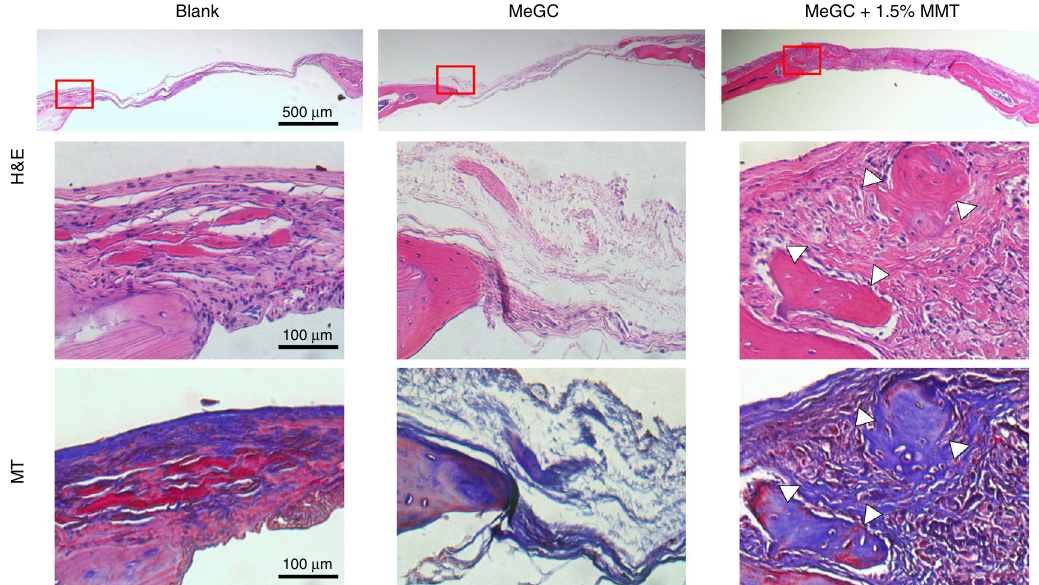
Fig. 9 Histological analysis of bone regeneration in calvarial defects, 6 weeks post surgery. Hematoxyline and eosin (H&E) staining (scale bar = 500 μ m), and magni fi ed images of H&E and Masson trichrome staining (red boxes represent the magni fi ed areas, scale bar = 100 μ m; arrowheads indicate the new bone